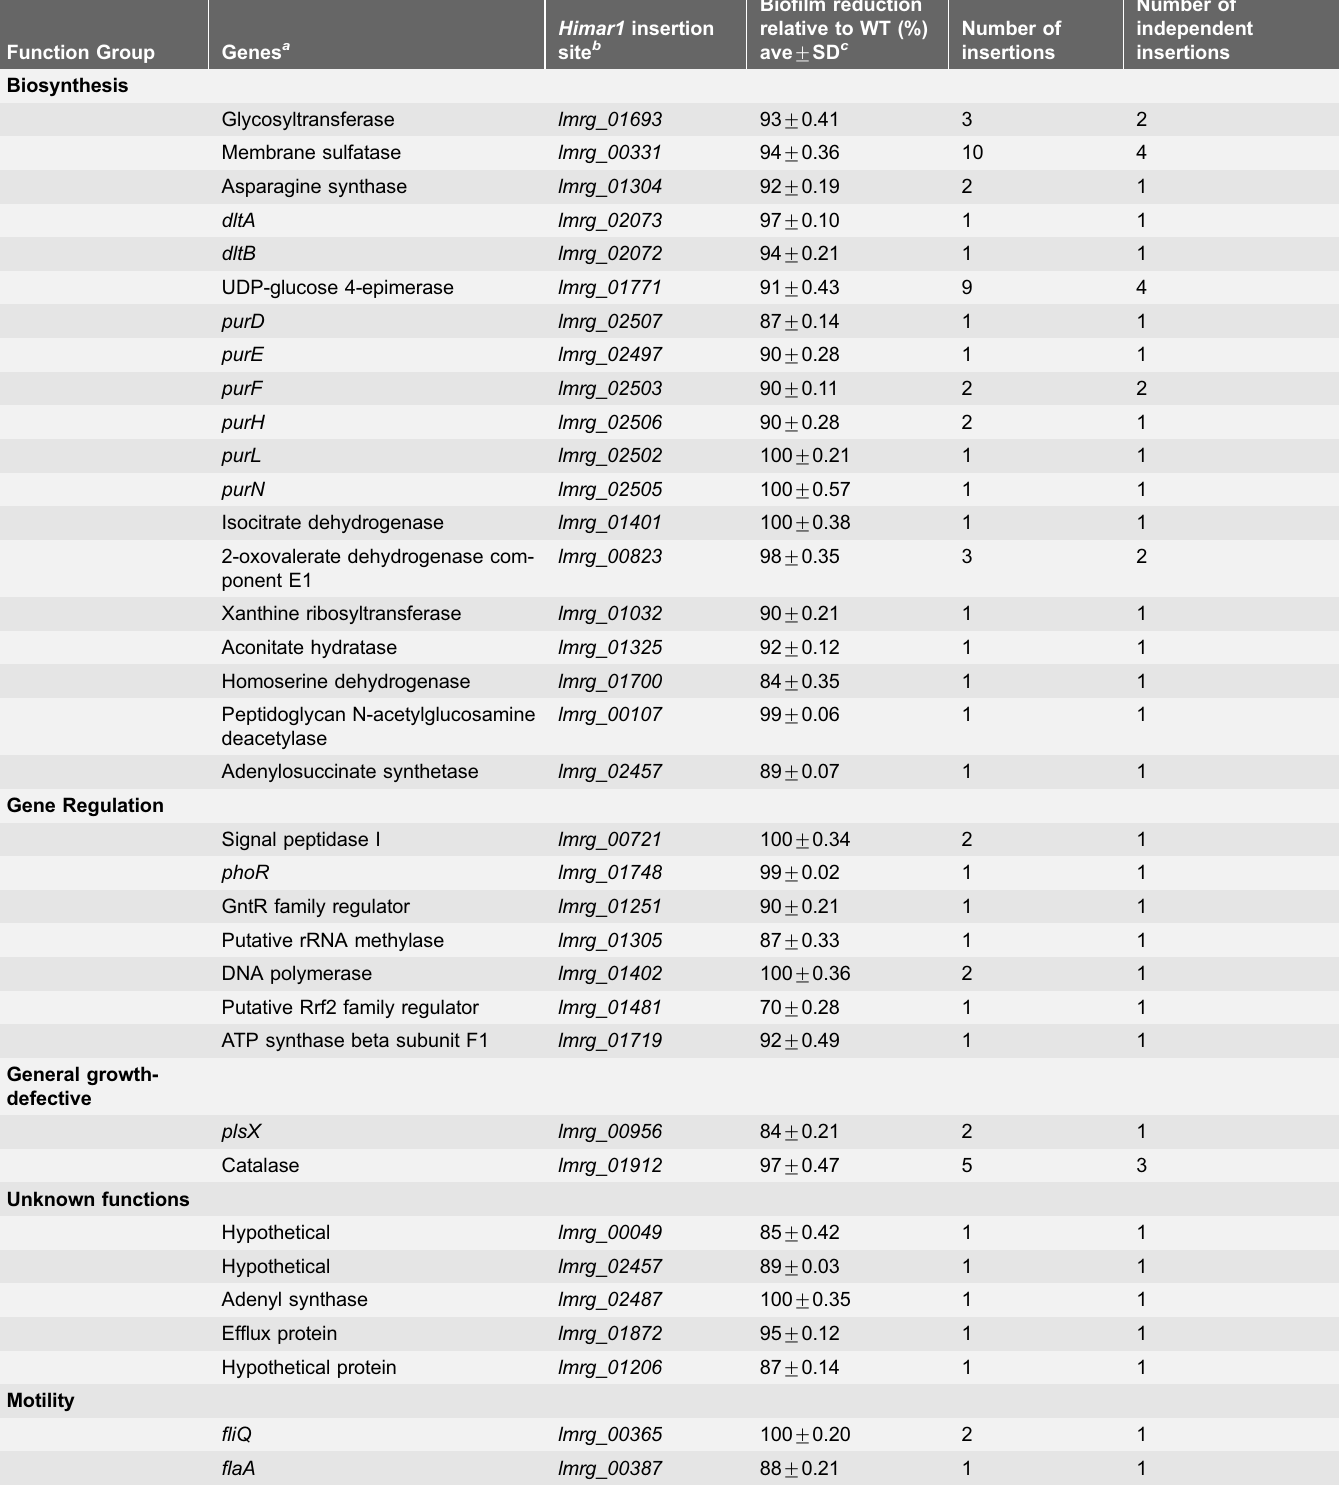
Table 1. Identified L. monocytogenes biofilm-formation